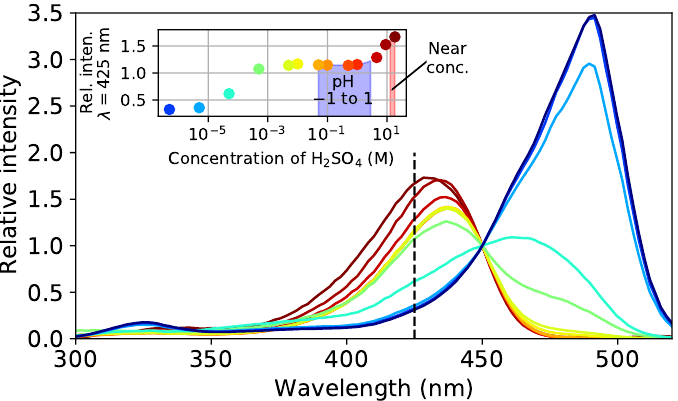
Figure 5. Excitation spectrum of fluorescein at different acid concentrations. Spectra are normalized at the wavelength of 450 nm. Inset: Relative intensities at 425 nm, showing a clear dependence on sulfuric acid concentration. Approximate regions for both acidity hypotheses: pH between − 1 and 1 and near concentrated sulfuric acid have been